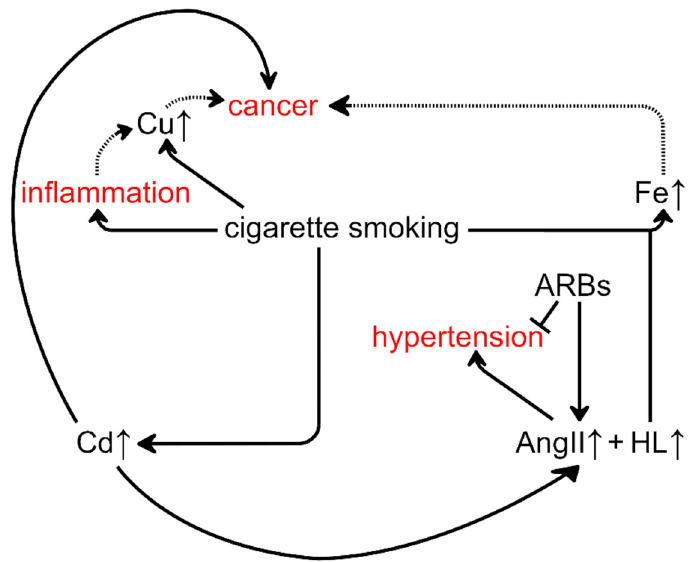
Figure 2. Interdependence of cigarette smoking, hypertension, and cancer, based on this work and that described in the literature. Solid arrows represent confirmed associations and dotted arrows indicate less firmly documented or controversial ones. Cigarette smoking has harmful effects, including carcinogenesis and hypertension. Furthermore, our results show that simultaneous exposure to smoke and HL increases the concentration of Fe in the lungs. The concentration of HL probably increases commensurately with that of angiotensin II (AngII) during anti-hypertension therapy using angiotensin receptor blockers (ARBs). A detailed description of these pathways is provided in the Results and Discussion section.